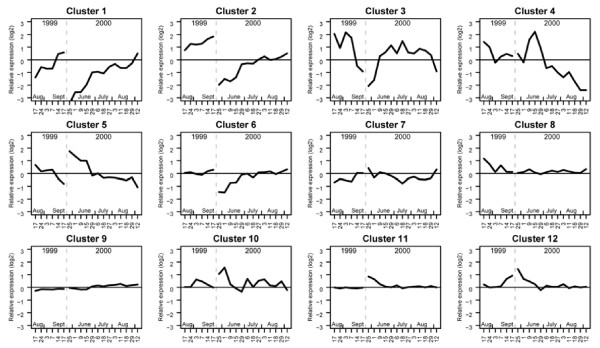
The twelve most common protease expression patterns during Populus leaf development. Populus DNA microarray data were processed in UPSC-BASE (Sjödin et al. 2006). Samples for microarray analysis were taken from free-growing aspen in Umeå on the following dates; May 25, June 1, June 9, June 15, June 29, July 6, July 18, July 27, August 3, August 11, August 18, August 29 and September 12 2000, and Aug 17, Aug 24, Sept 03, Sept 07, Sept 14 and Sept 17 1999. The two sample series are identified by separate lines in the profiles.